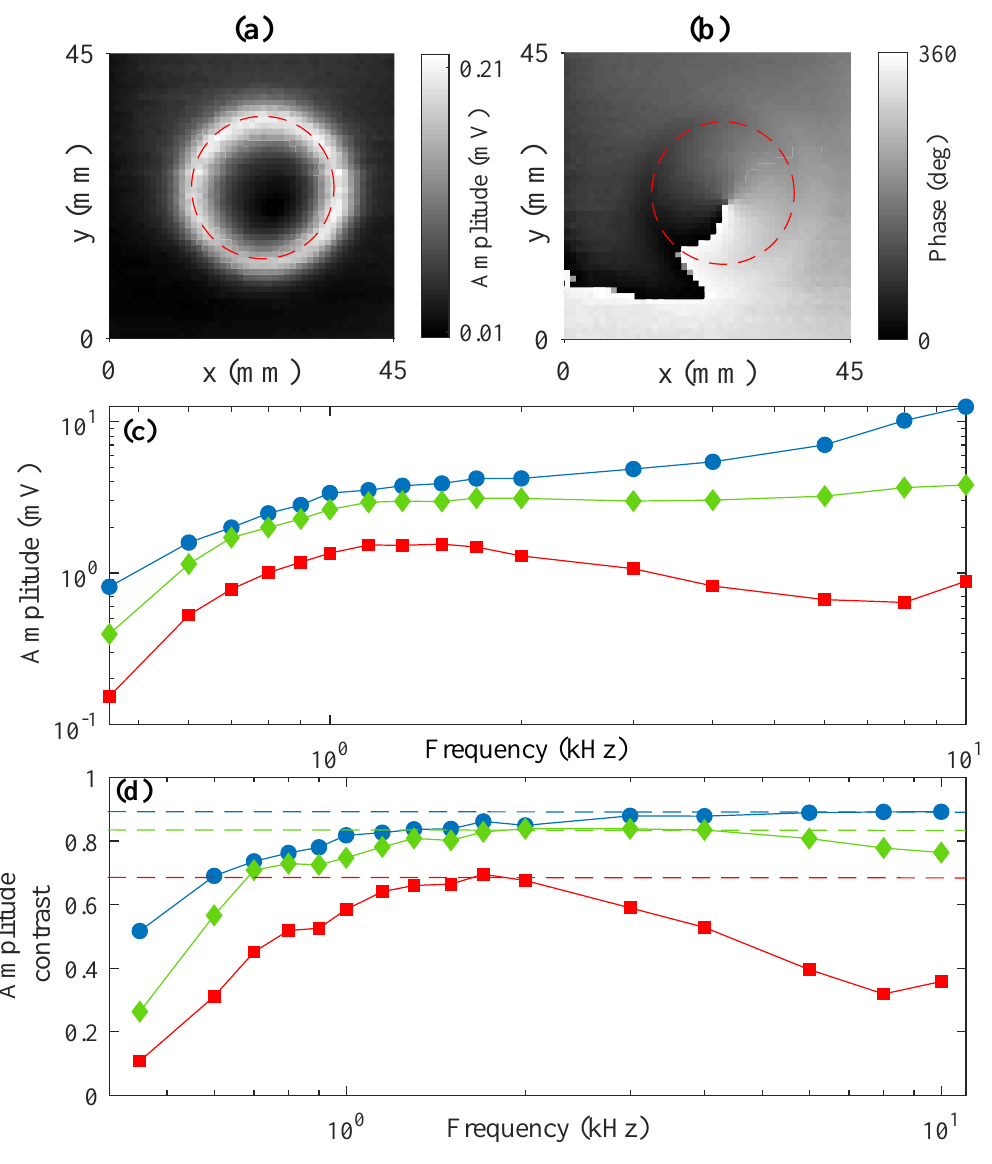
Figure 4. The measured change of the amplitude ( a ) and phase ( b ) of the rf spectroscopy signal recorded in the self-compensation configuration over a 90 × 90 mm 2 area of a 6mm-thick aluminium plate, containing a 50mm-diameter recess that is 2.4mm-deep at 2 kHz. The red dashed line marks the position of the recess edge. The amplitude ( c ) and contrast ( d ) of the profile in the amplitude image representing the recess as a function of the rf primary field frequency. The dependence is recorded with the recess covered by zero (blue dots), one (green diamonds), and three (red squares) 0.5mm-thick aluminium